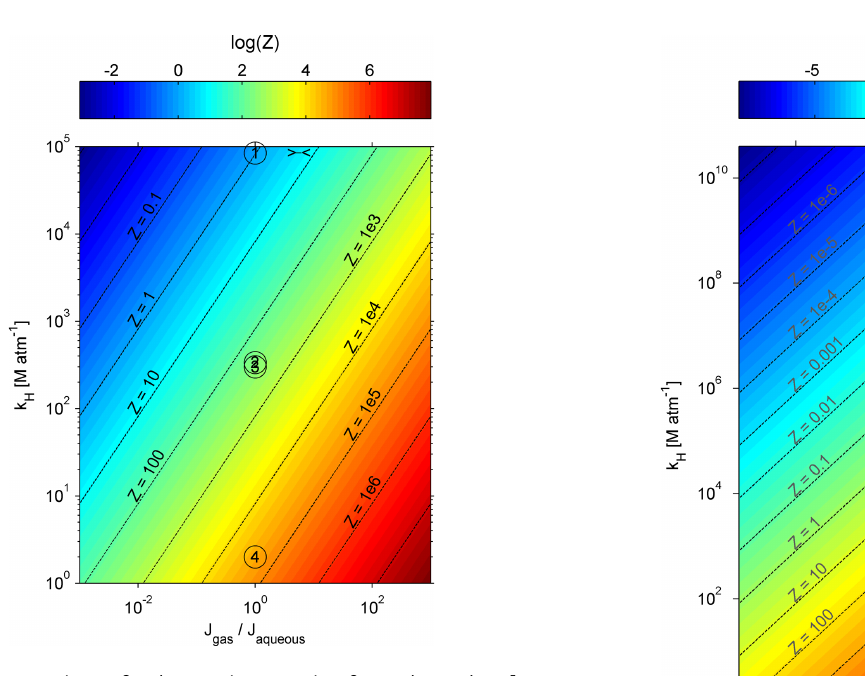
Fig. 2. Best estimate for the maximum ratio of gas phase photol- ysis to aqueous phase photolysis, Z , for a series of peroxides and methyl nitrate in an air parcel with a LWC = 0.5gm − 3 at 298K. Species are labeled in order of increasing Z : (1) hydrogen perox- ide, (2) ethyl peroxide, (3) methyl peroxide, and (4) methyl nitrate. The two inward arrows adjacent to “1” show the range of Z for hy- drogen peroxide across all solar zenith angles with experimentally measured gaseous and aqueous rate constants from (Sander et al., 2011; Chu and Anastasio, 2005).